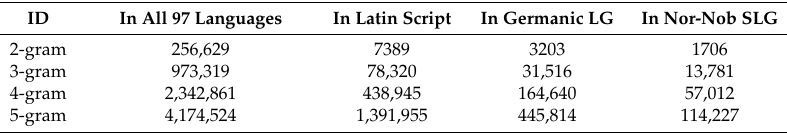
Table 10. Different N-gram numbers in different LI corpora.